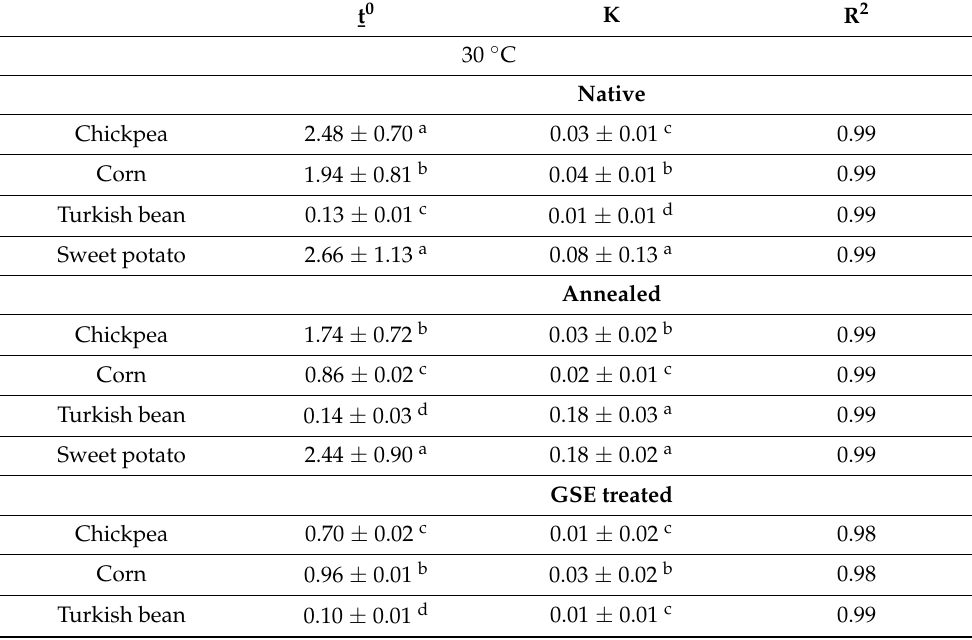
Table 2. Effect of annealing and germinated sorghum extract on Herschel–Bulkley model parameters (T 0 , K , n ) of chickpea, corn, Turkish bean and sweet potato starches tested at 30 ◦ C and 40 ◦